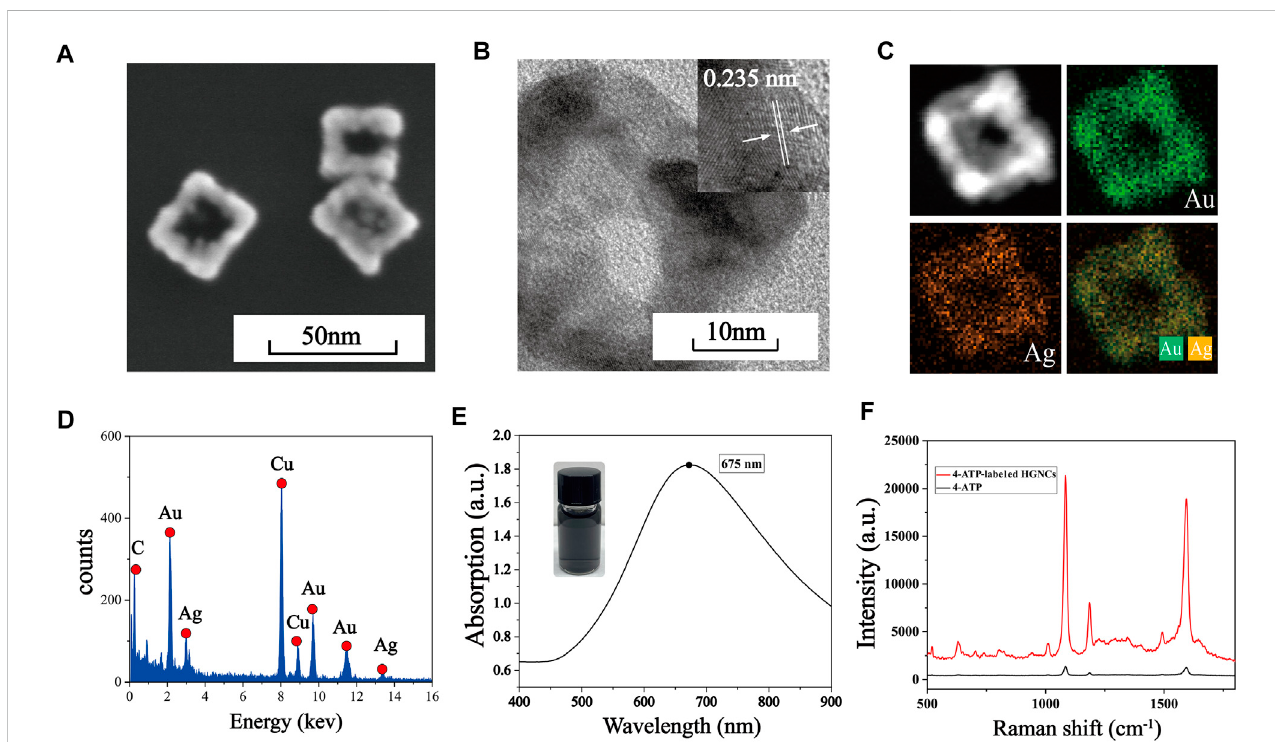
FIGURE 1 (A) SEM image of Au-AgNCs. (B) HRTEM image of Au-AgNCs. (C) HAADF-STEM image and elemental mappings of Au-AgNCs. (D) EDX spectrum of Au- AgNCs. (E) UV-Vis-NIR absorption spectrum of Au-AgNCs. (F) SERS spectra of pure 4-ATP and 4-ATP-labeled